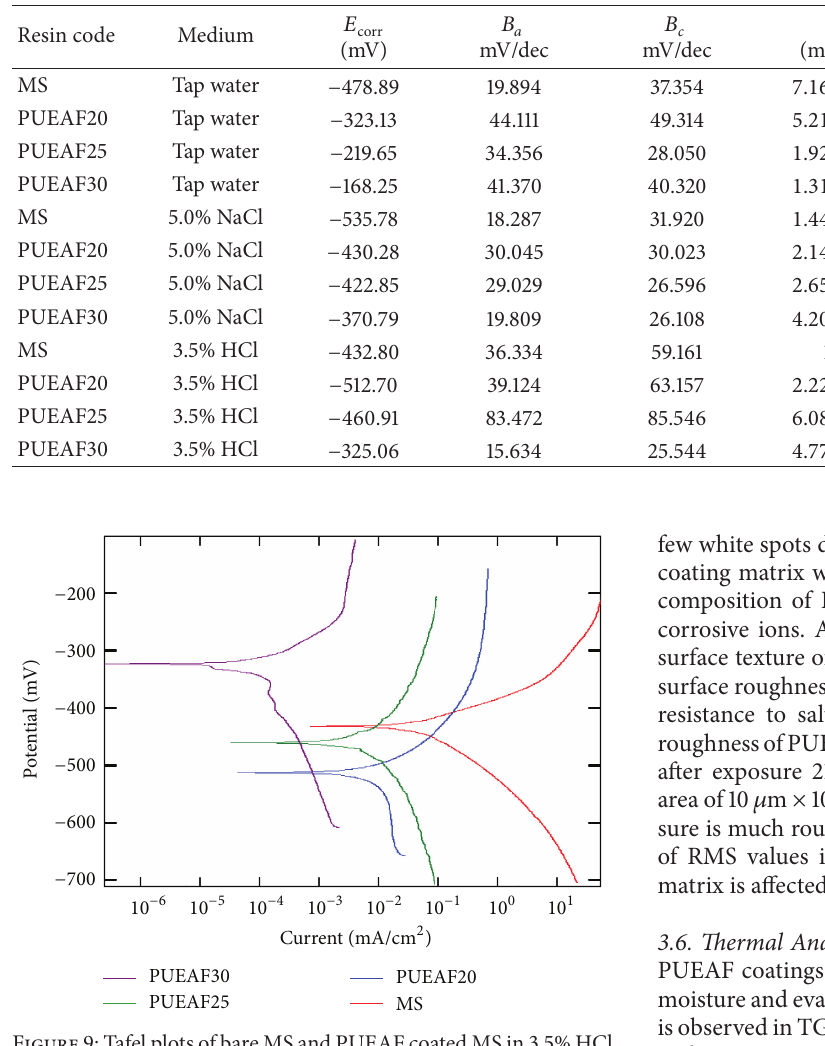
Figure 9: Tafel plots of bare MS and PUEAF coated MS in 3.5% HCl